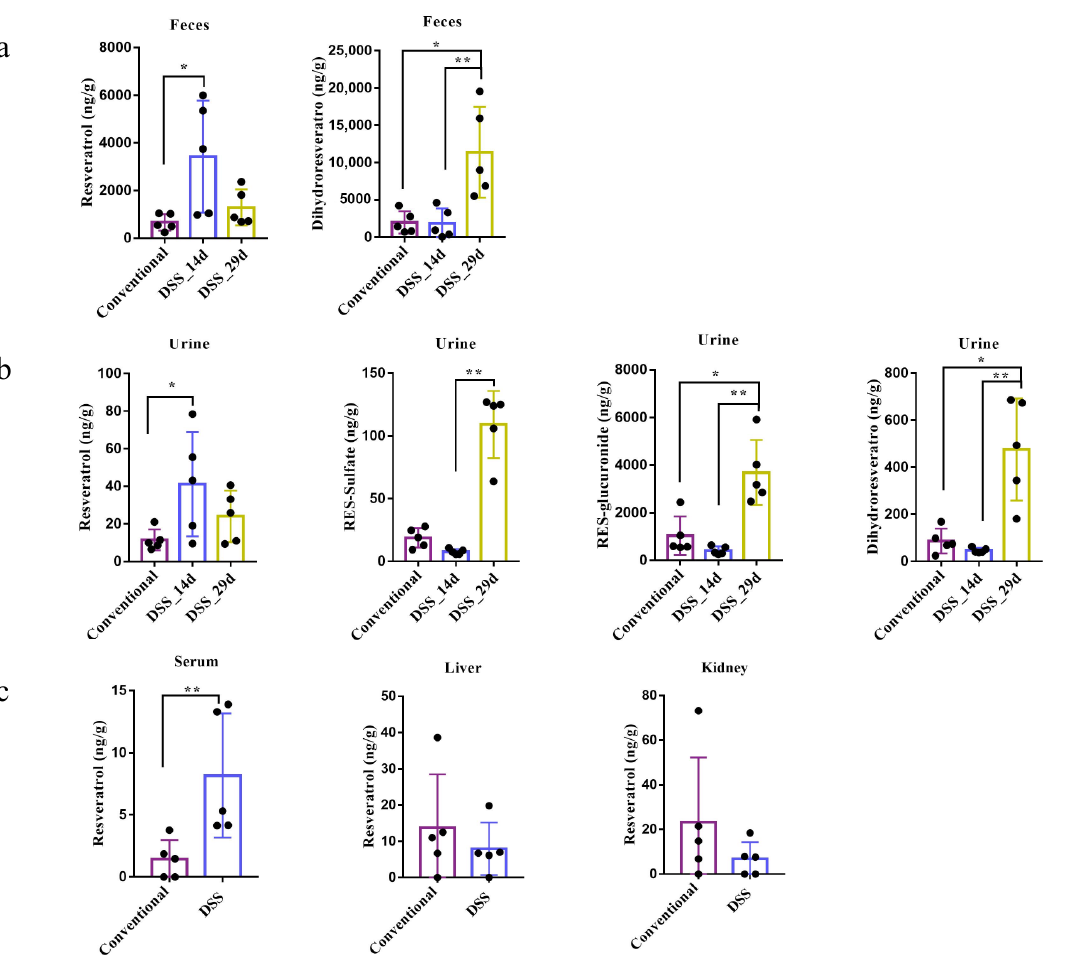
Figure 4. RSV metabolism and distribution in conventional mice and DSS-induced colitis mice after oral administration. RSV and its metabolites were quantified in feces ( a ), urine ( b ), serum, and tissues ( c ) of both conventional mice and DSS-induced mice. 14 d and 29 d present different duration of RSV intervention. Data are presented as mean ± SEM ( n = 5). Significant difference was represented by * p < 0.05, ** p < 0.01, and analyzed by independent-samples t -test and one-way ANOVA with LSD’s post hoc test or nonparametric test (Mann–Whitney U-test and Kruskal–Wallis H test).